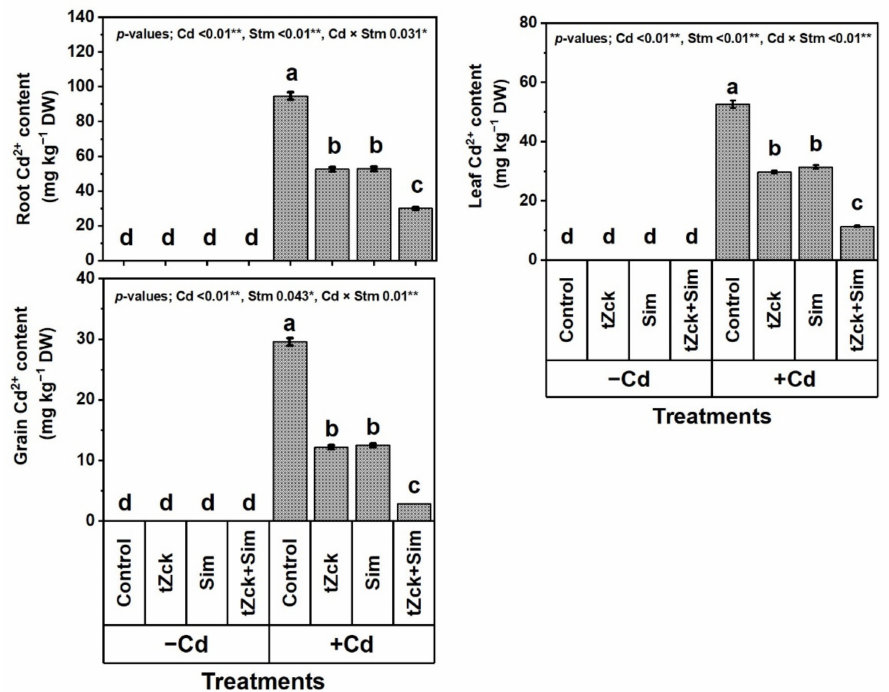
Figure 5. Root, leaf and grain cadmium (Cd) contents of wheat plants (cv. Sakha 93) treated with two stimulators (Stm) i.e., silymarin (Sim; 0.5 mM) and trans -zeatin-type cytokinin (tZck; 0.05 mM) under Cd (0.6 mM) stress. The same letters with mean values ± SE in each plot indicate non-significant differences based on the LSD test ( p ≤ 0.05). * and ** refer to significant difference at p ≤ 0.05 and p ≤ 0.01, respectively. t Zck; trans -zeatin-type cytokinin, Sim; silymarin, − Cd; without cadmium treatment, +Cd; cadmium treatment and Stm;